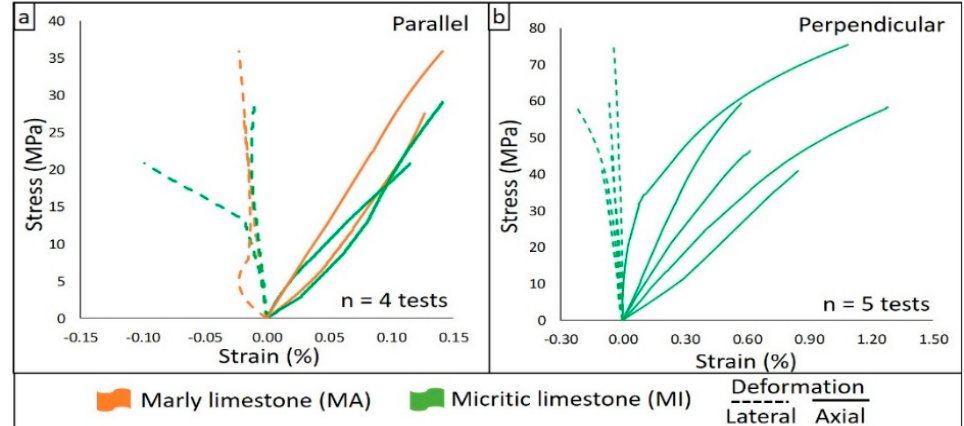
Figure 7. Stress–strain curve for UCS tests with strain measurements. Samples are grouped by lithology and orientation of bedding planes. Samples with silica bands are not plotted in the graph (see Section 5.3), with ( a ) the stress–strain curves for PA samples and ( b ) the stress–strain curves for PE samples. The solid line shows the axial deformations, and the dashed line shows the lateral de- formations. Table 7. Summary of Uniaxial Compressive Strength (UCS), crack closure stress (CC) and crack initiation stress (CI) levels, for marly and micritic limestone from Member I, Thebes Limestone For- mation. Brackets indicate the thresholds in ratio of stress to UCS. Samples with silica bands were excluded here and average UCS of the remaining tests are given. # stands for number.